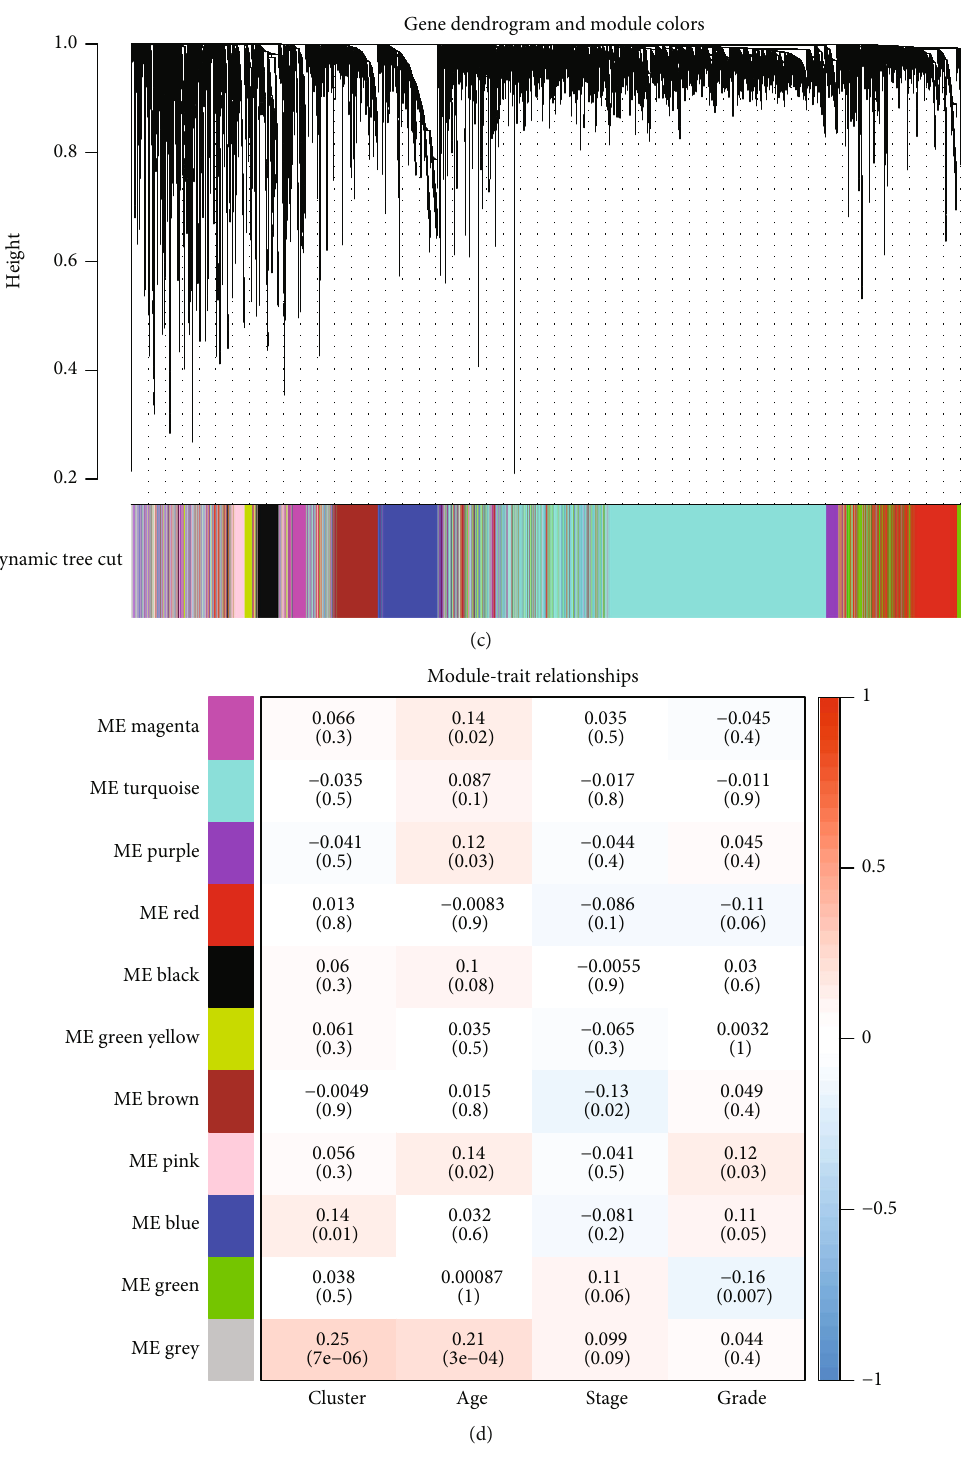
Figure 2: Identi fi cation of di ff erential molecular subtype genes associated with ferroptosis. (a, b) mRNA-seq di ff erential analysis of cervical cancer and normal tissue heat maps and volcano plots, with red for highly expressed genes and green for lowly expressed genes. (c) Based on the hierarchical clustering analysis of TCGA dataset, genes with similar characteristics are assigned to modules of the same color. (d) Heat map of correlations between eigenvalues and individual modules, red indicates positive correlation and blue indicates negative